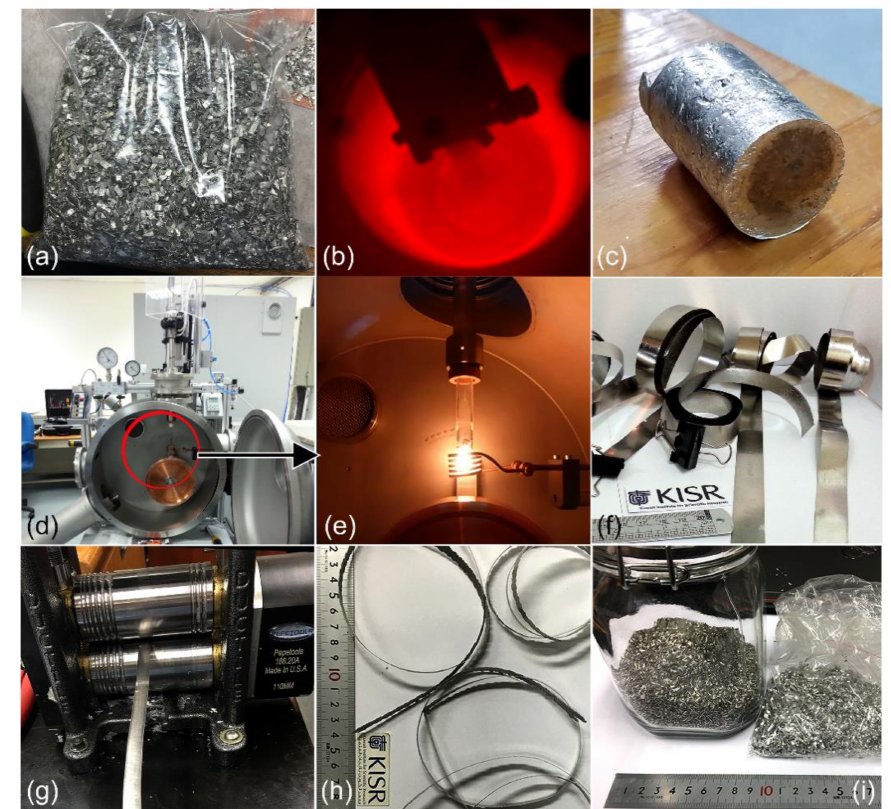
Figure 1. Conversion of solid-waste (SW) Mg machining chips into microscaled Mg-shots. ( a ) as-received SW-Mg chips, ( b ) melting and casting processes, ( c ) as-casted pure (99.95 wt%) Mg-ingot, ( d ), ( e ) melt spinning (MS) process, ( f ) as-MS Mg-ribbons, ( g ) cold rolling (CR) process, ( h ) as-CR Mg-strips, and ( i ) as-snipped